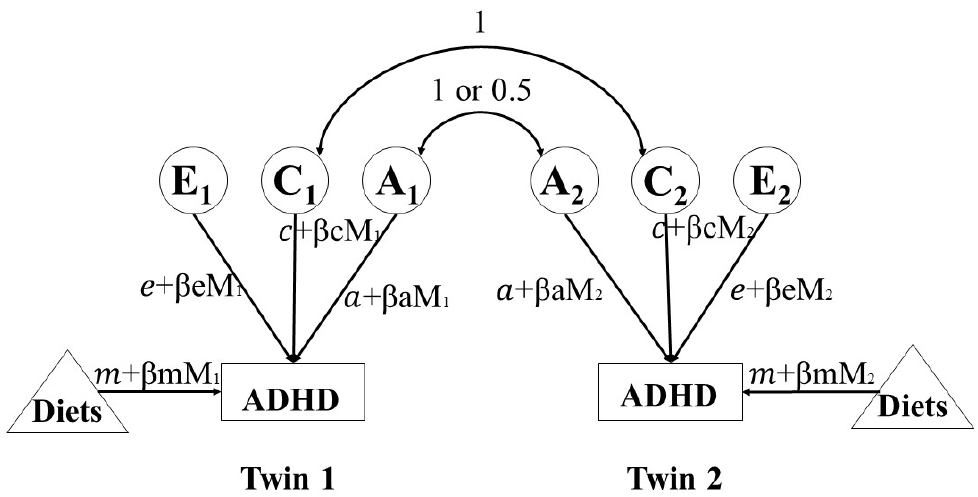
Figure 1. Path diagram for gene–environment interaction model. A: additive genetic influences; C: shared environmental influences; E: non-shared environmental influences; A is correlated to 1 between monozygotic twins (MZ) and 0.5 between dizygotic twins (DZ), respectively; C is correlated to 1 for both MZ and DZ twins; a, c, and e: unmoderated components; β a, β c and β e: moderated components of a, c, and e; m: grand mean; β m: effect of moderator (diets). ADHD: Attention-Deficit/Hyperactivity Disorder.